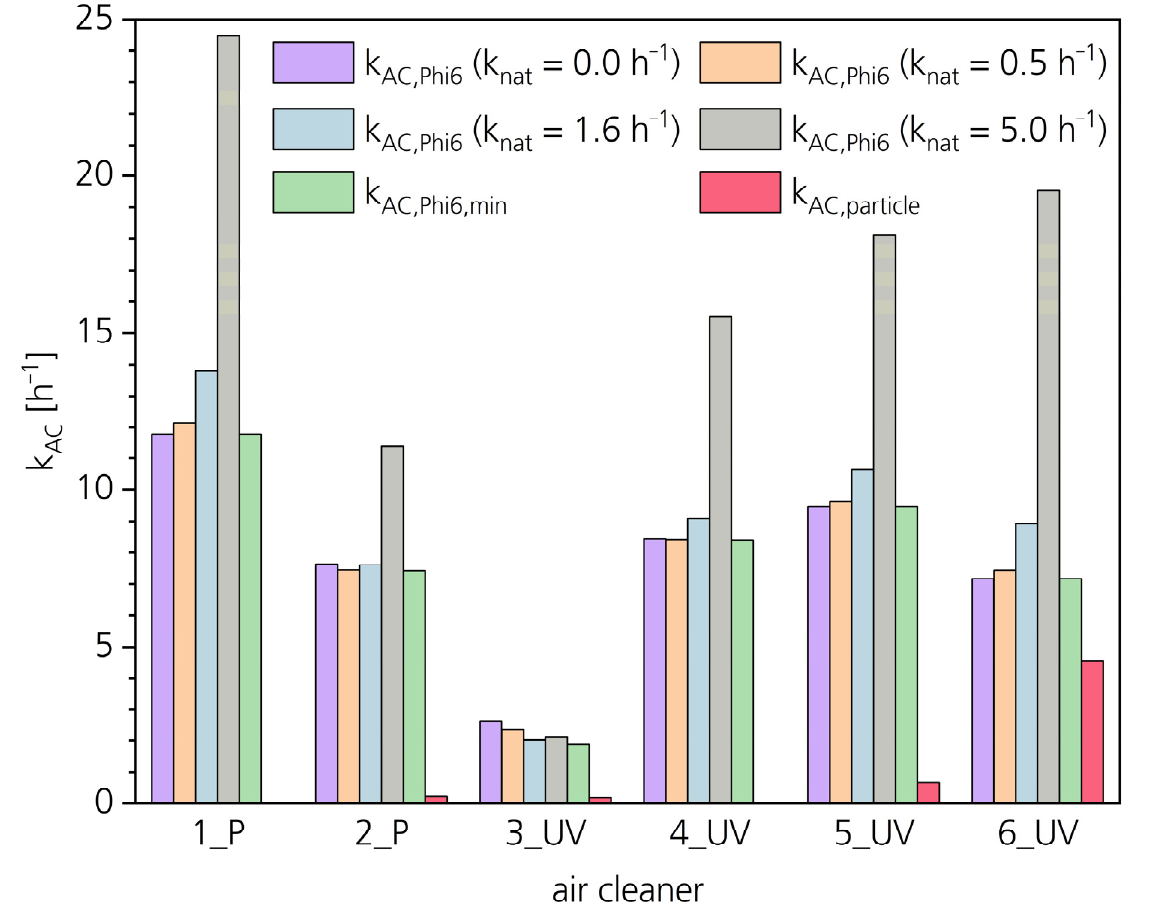
Figure 3. Air cleaner loss coefficients k AC,Phi6 and k AC,particles for all six air cleaners determined by the evaluation model according to [54] based on Equation (1) for four different values of parameter k nat . The loss coefficients k AC,Phi6,min of the air cleaners are the lowest k AC,Phi6 values that could be received by variation of the parameter k nat .